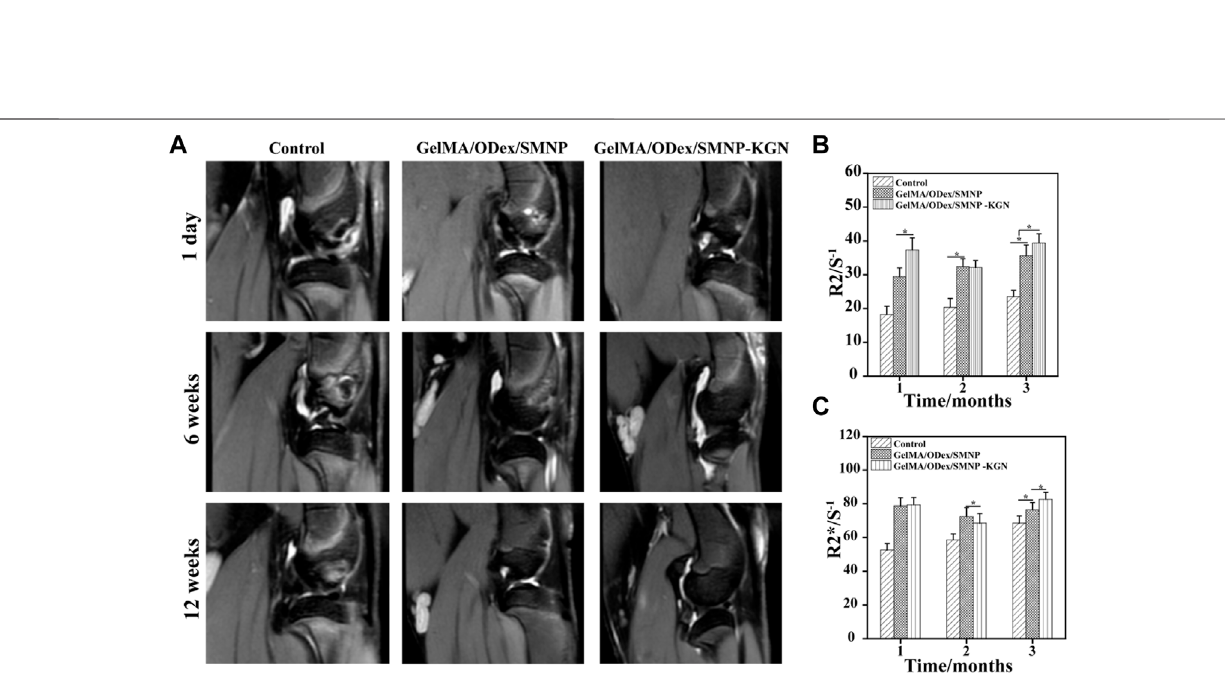
Frontiers in Bioengineering and Biotechnology |